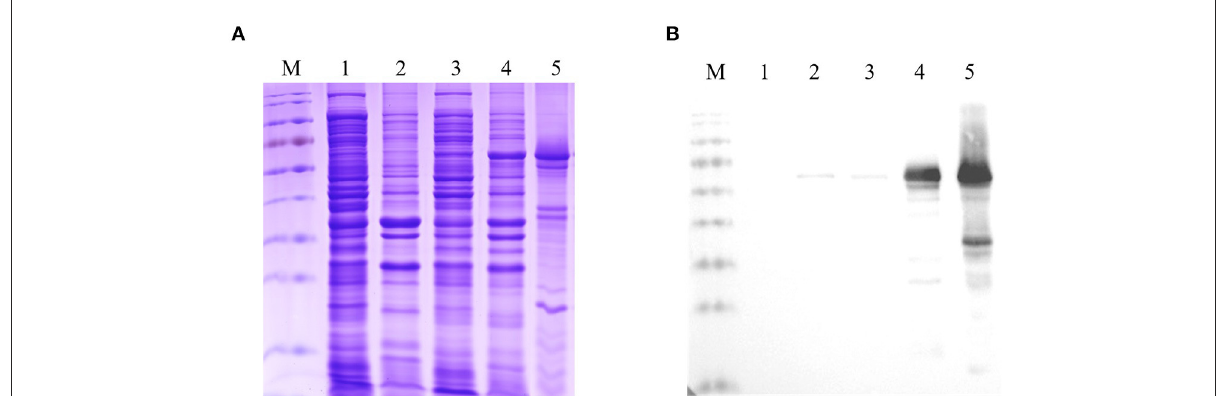
FIGURE1 Identification of the expression and purification of the recombinant Fiber-1. (A) SDS-PAGE analysis for the expression and purification of the recombinant Fiber-1 in E. coli . (B) Western blot analysis for the expression and purification of the recombinant Fiber-1 by using anti-His mAb. Lane M: Protein Marker. Lane 1 and 2: the supernatant and the precipitation of the lysate of E. coli BL21 transfected with pCold-I, respectively. Lane 3 and 4: the supernatant and the precipitation of the lysate of E. coli BL21 transfected with pCold-I-Fiber-1, respectively. Lane 5: the purified Fiber-1 using urea